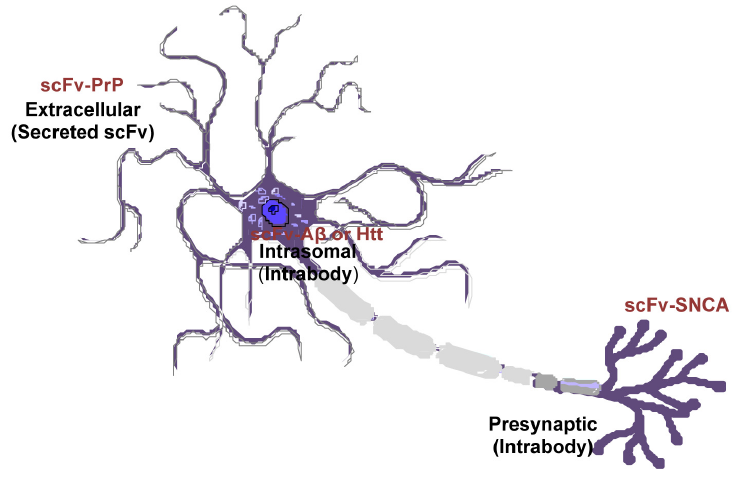
Figure 5. Differential cellular location of single-chain fragment variable (scFv) that targets specific pathogenic antigen in different neurodegenerative diseases. Recombinant adeno-associated virus (rAAV)-scFv can be engineered to localized to desired subcellular regions extracellular